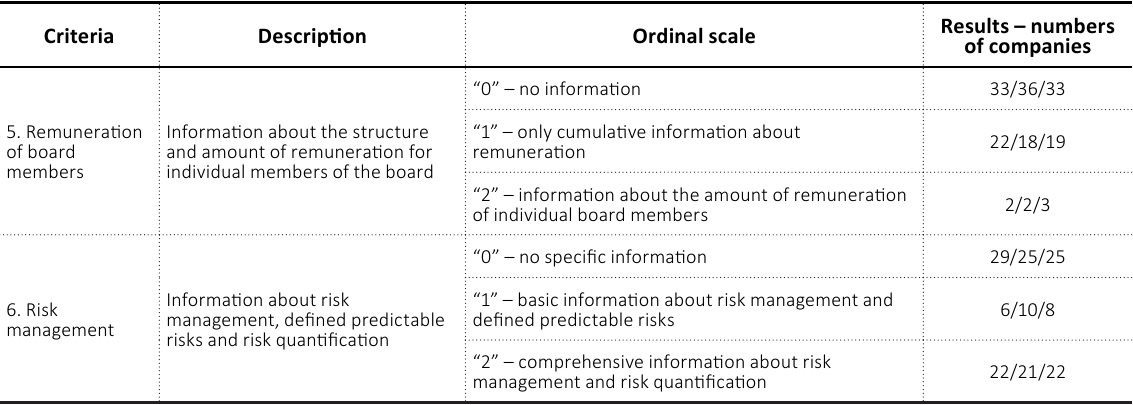
Table B1. Evaluation of 5th and 6th criteria and results